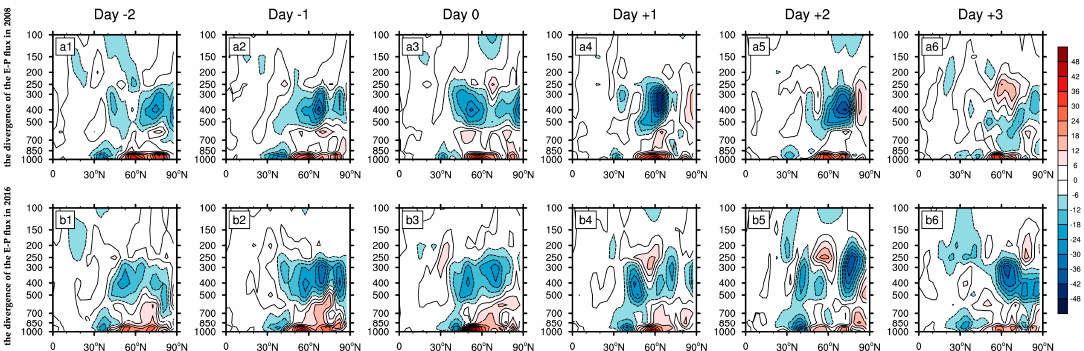
Figure 6. Pressure-latitude cross section of the divergence of Eliassen-Palm (E-P) flux during the two cold events. Unit: m · s − 2 . (a1–a6, b1–b6 indicate the divergence of E-P flux from January 16 to 21 in 2008 and January 19 to 24 in 2016, respectively.)